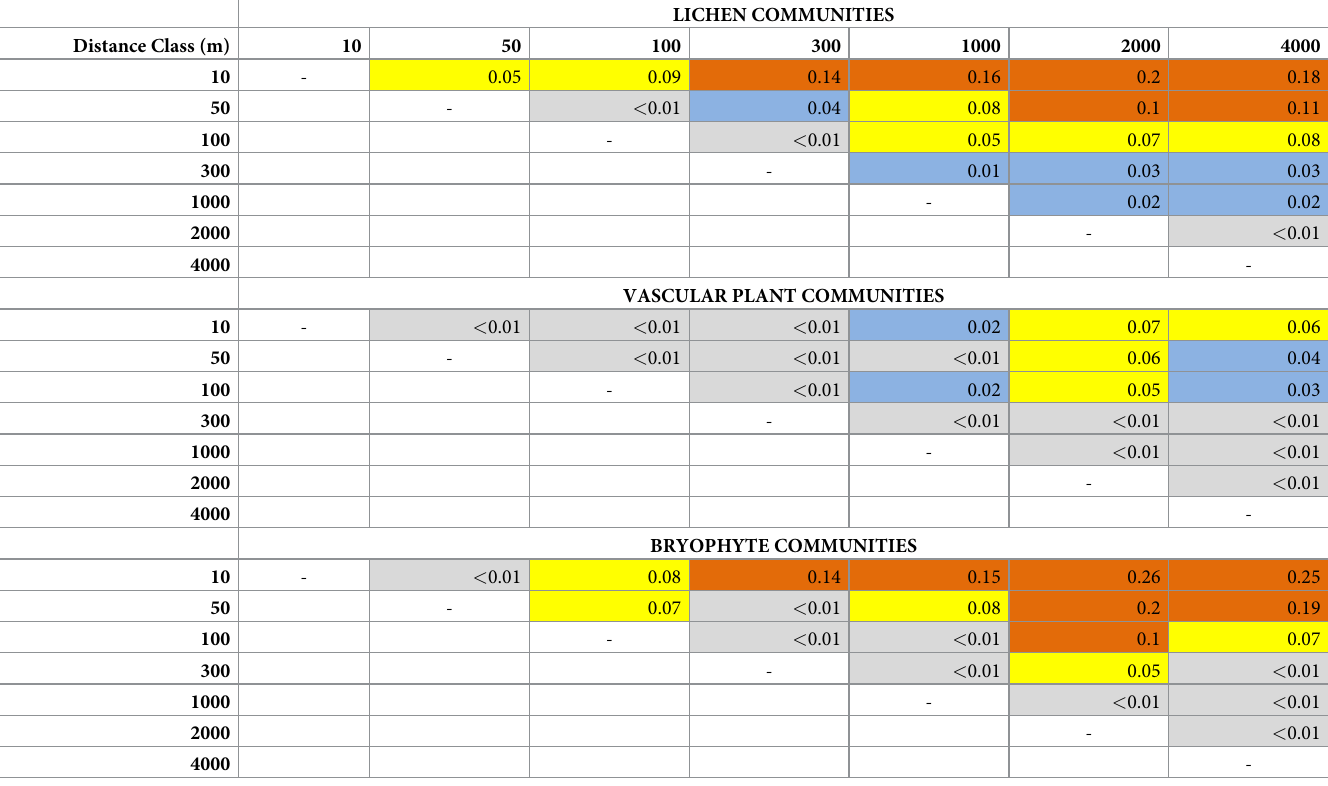
Table 4. MRPP A-statistics from pairwise comparisons plot distance classes for lichen, vascular plant and bryophyte communities. Color shadings reflect groupings of strong (red), moderate (yellow) and weak (blue) or little (black) community differences. Community differences were evaluated using Sorenson distance measure on log 10 transformed matrices of: lichens (91 plots x 93 species), vascular plants (91 plots x 56 species) and bryophytes (91 plots x 5 species